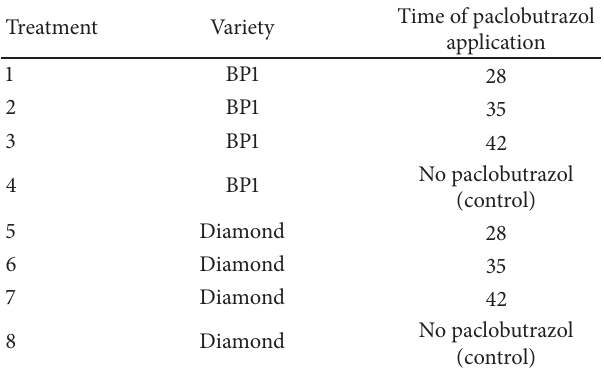
Table 1: Treatment structure for the effect of time of paclobutrazol application on growth, quality, and yield of